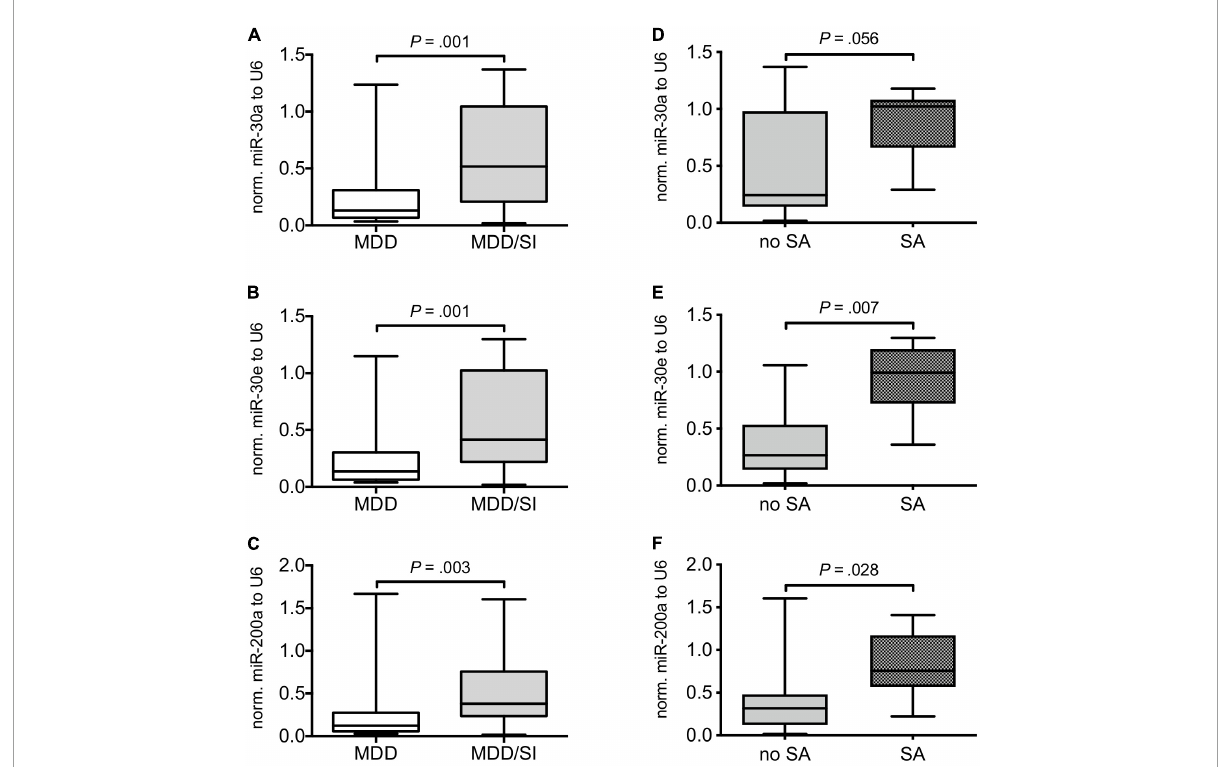
FIGURE1 Comparison of relative miRNA expression in MDD patients with and without acute suicide risk and in suicidal MDD patients with and without suicide attempt. Boxplots depict median with interquartile range and whiskers depict minimum and maximum values. The left panel shows relative miR-30a (A) , miR-30e (B) , and miR-200a (C) expression normalized to U6 in MDD patients without (MDD) and in MDD patients with (MDD/SI) acute suicide risk. The right panel depicts relative levels of miR-30a (D) , miR-30e (E) , and miR-200a (F) in suicidal patients with (SA) and without (no SA) suicide attempt. Exact, two-tailed P -values were computed by use of Whitney-Mann U test and P < 0.05 was considered statistically